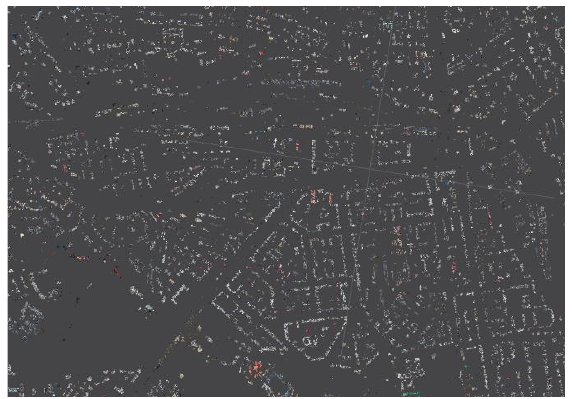
Figure 7-a. Tie points found using masks